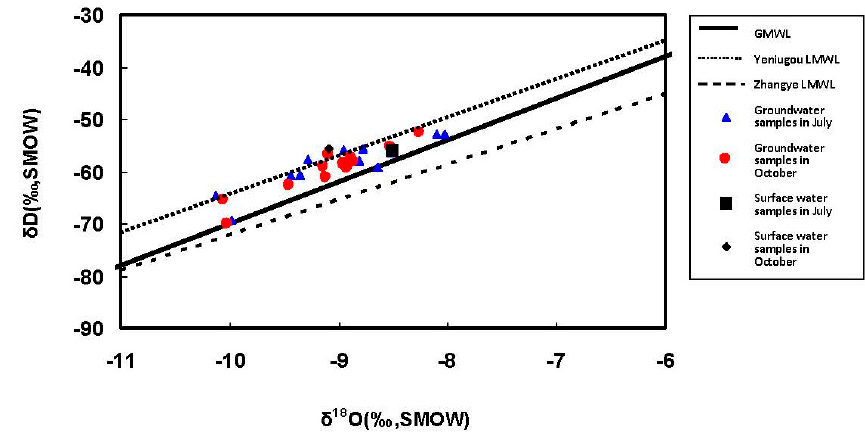
Figure 5. Plot of D versus 18 O for groundwater and surface water in the study area.